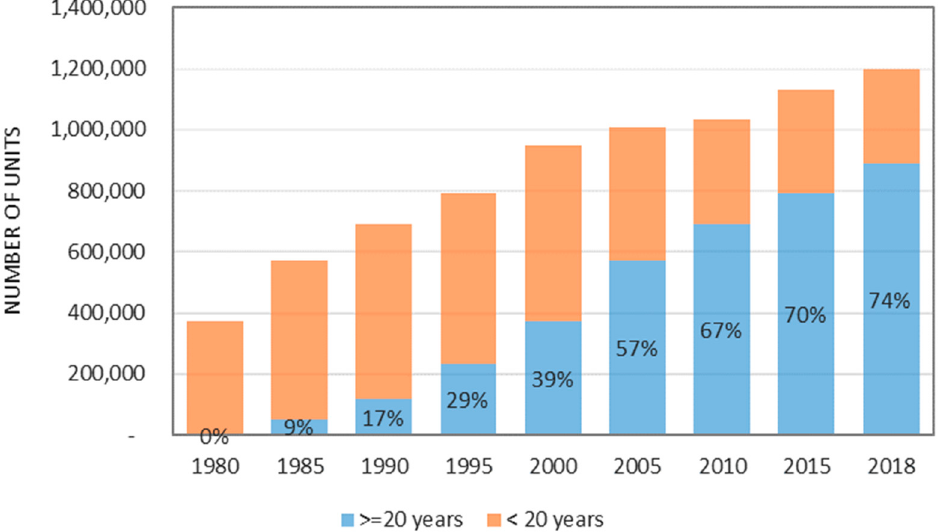
Figure 1. Percentage of public residential buildings in Singapore exceeding the age of 20 years [2].